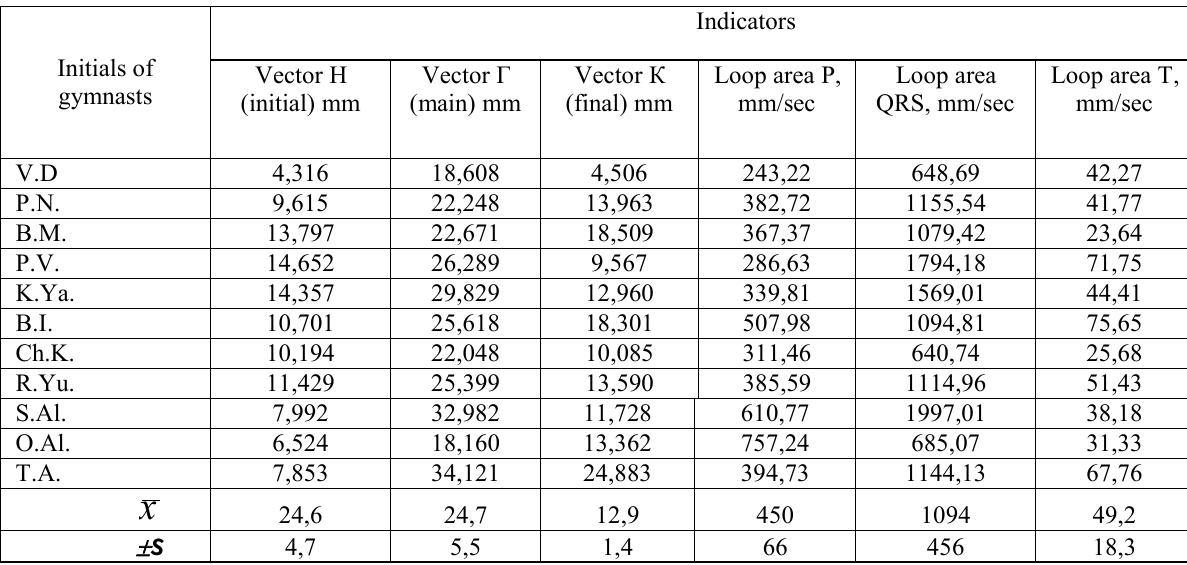
Quantitative VCG indicators of gymnasts of the first